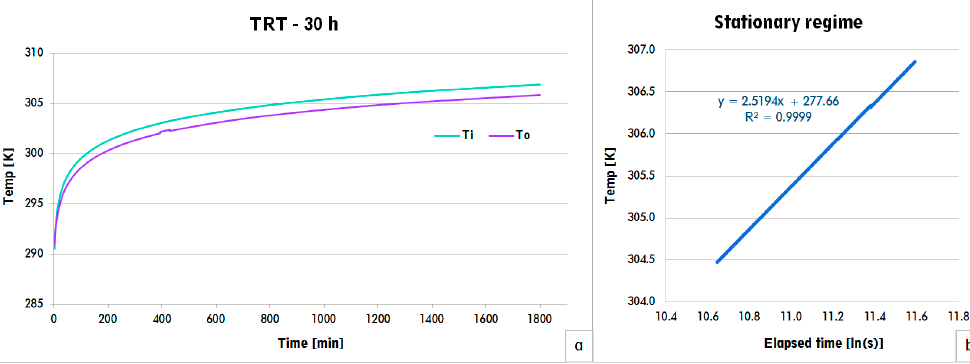
Figure 4. ( a ) TRT results for the time lapse of 20 h, ( b ) stationary regime considering 700 sampling values.